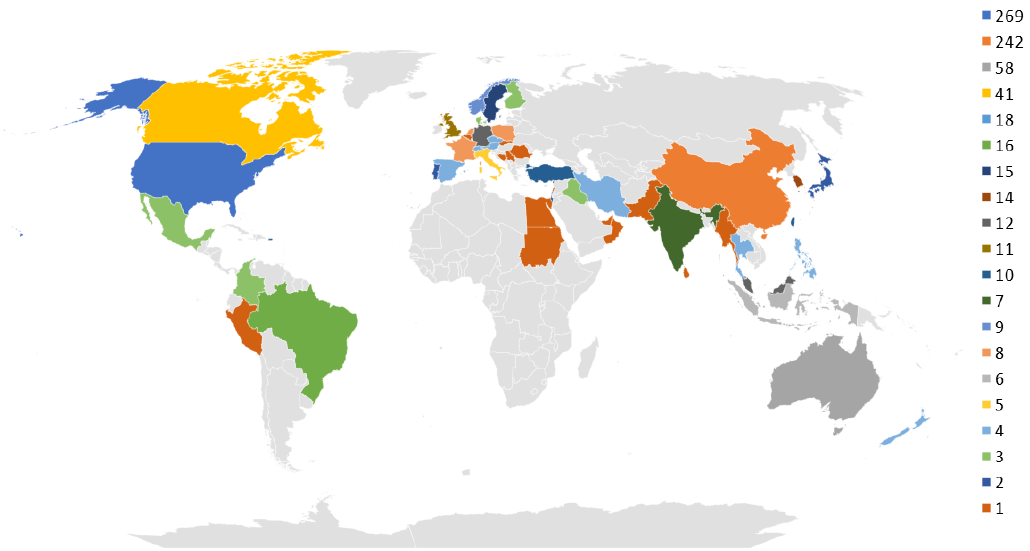
Figure 5. Country-wise analysis of studies published on BRCs, 2017–2022.